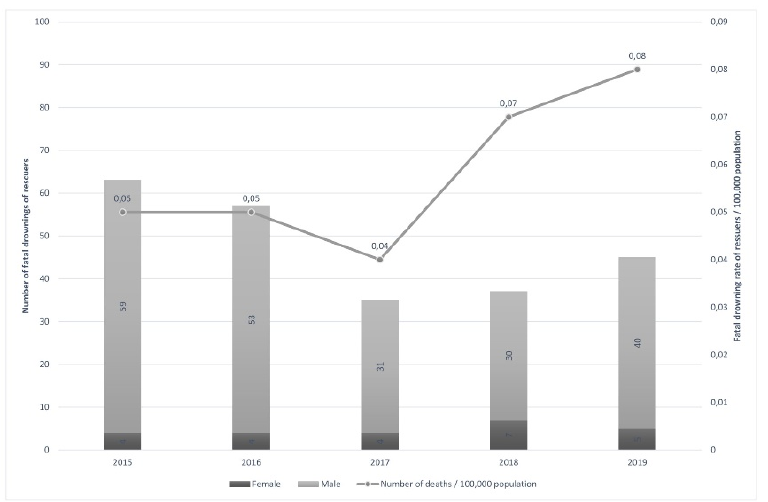
Figure 1. Frequency of unintentional bystander rescue-related fatal drowning and crude rate per 100,000 population by year of incident and sex; Turkey, 2015–2019. Table 1. Fatal drowning of bystander rescuers by status of rescue attempt, X 2 ( p value); Turkey, 2015–2019.